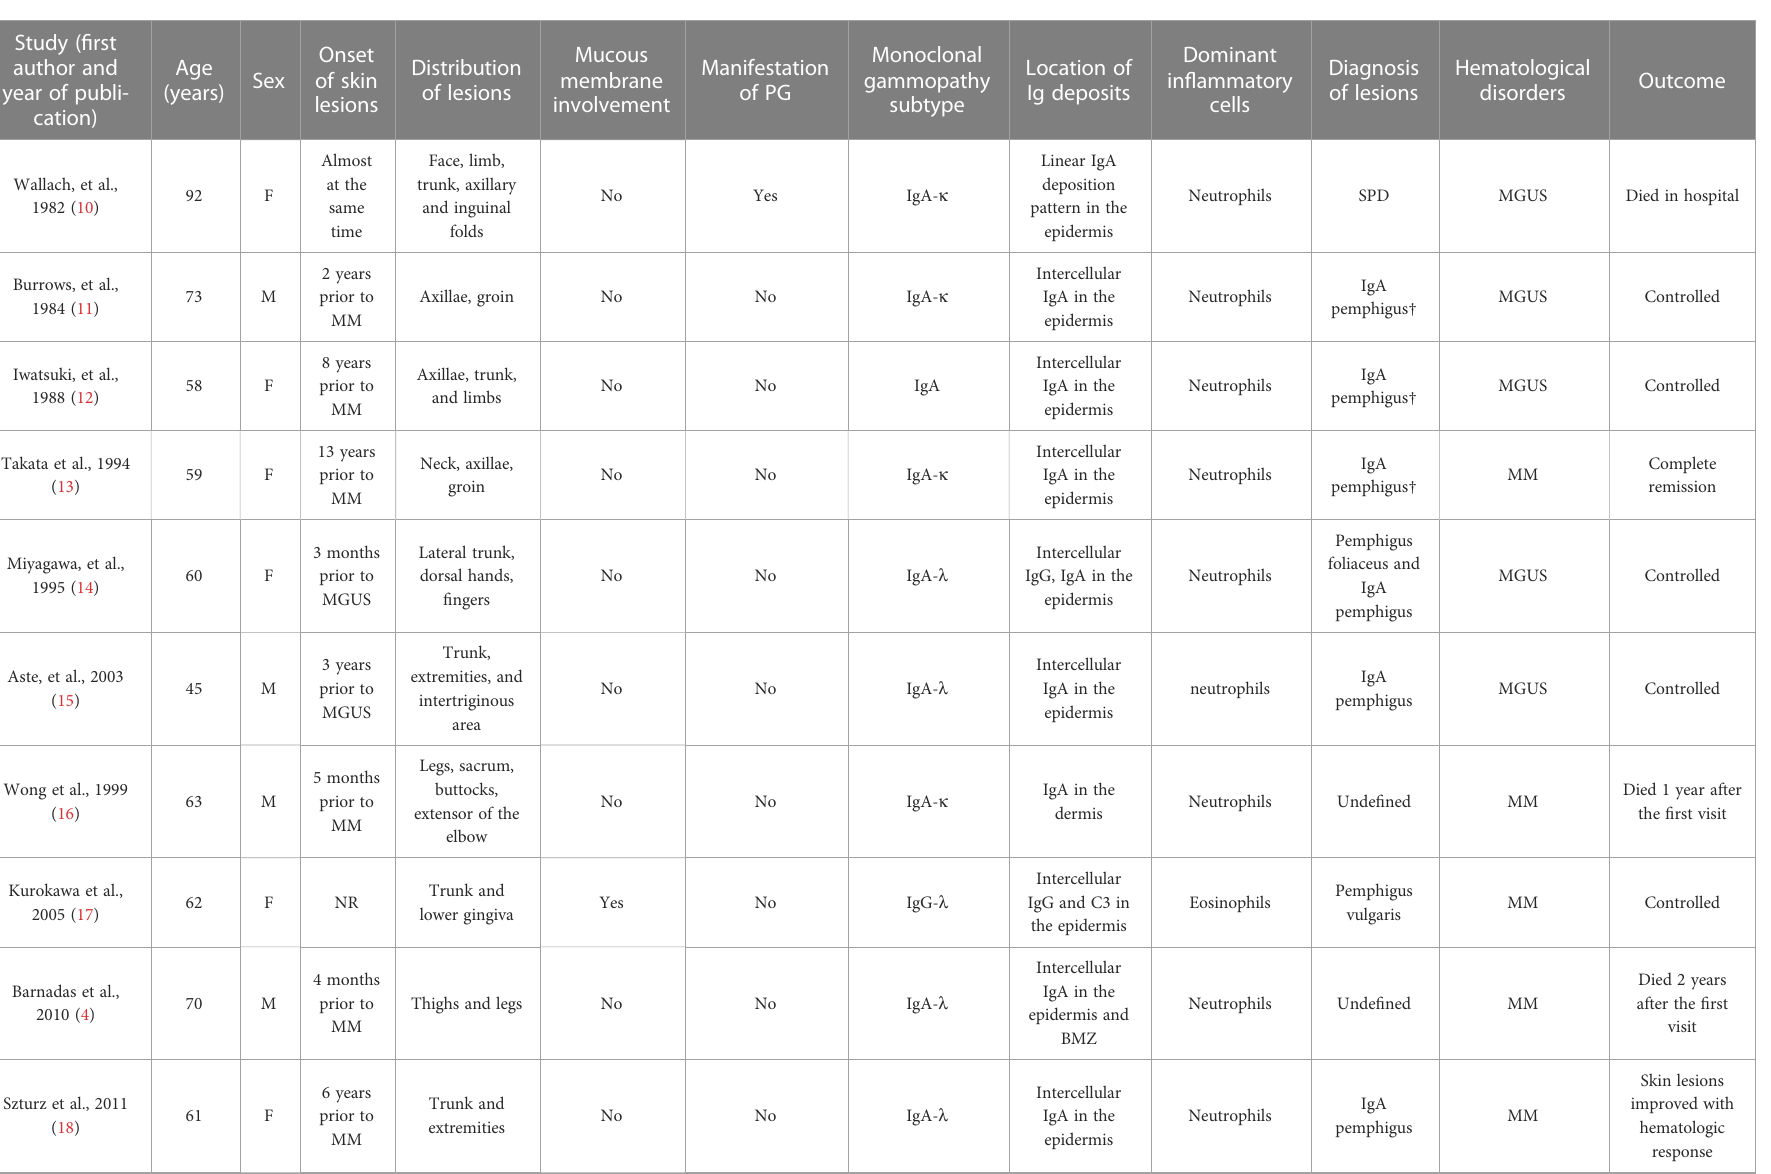
TABLE 1 Summary of the clinical features of AIBDs associated with MM or its